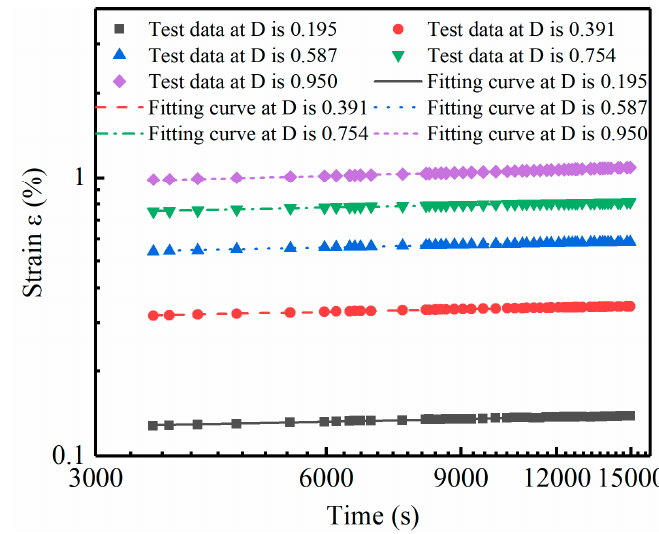
εε − diagram when t 1 = 1 h of soft soil at 18% water content. − D